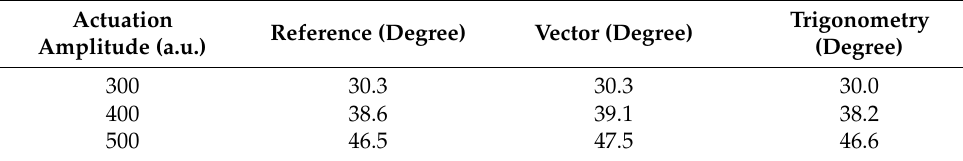
Table 1. Results of the dynamic